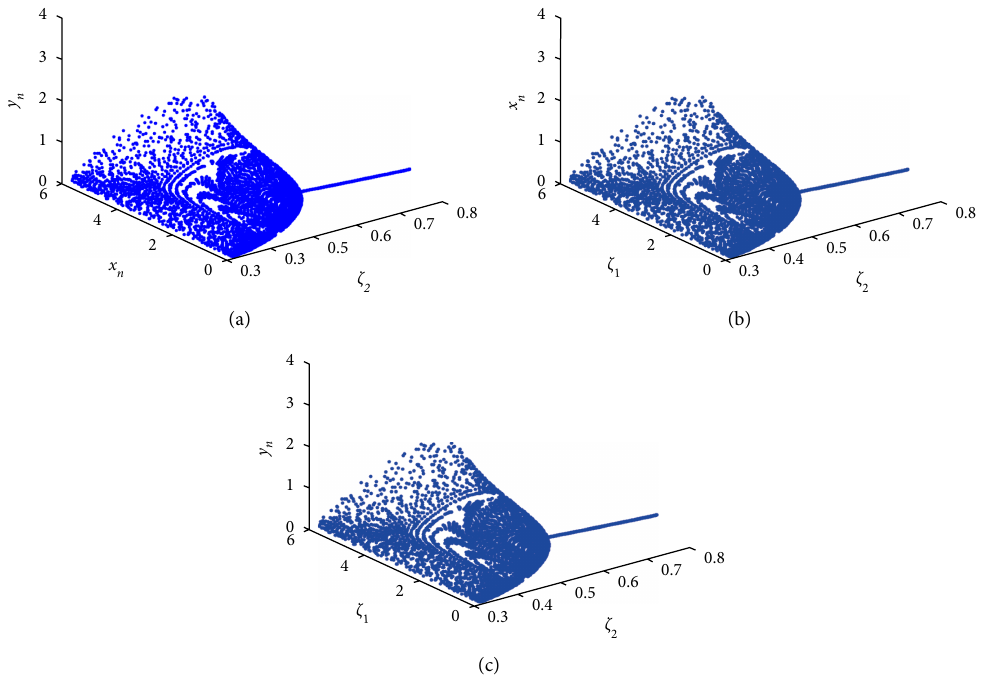
Figure 5: 3D bifurcation diagrams of the model with Maximum Lyapunov Exponent in this case, are plotted and drawn in Figure 4. Finally 3 D bifurcation diagrams are also plotted and drawn in Figure 5.